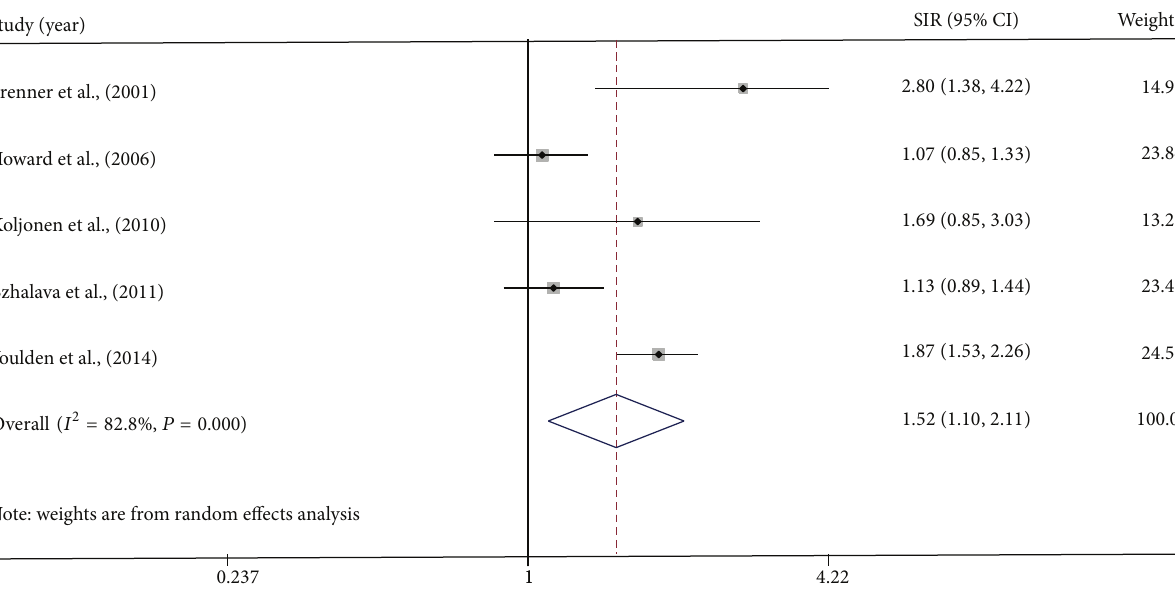
Figure 2: MCC and the risk of second cancer. Squares indicate the odds ratios for the individual studies; horizontal lines indicate the 95% confidence interval. The size of the data marker corresponds to the relative weight assigned in the pooled analysis using the random effects model. Diamond indicates the pooled odds ratios with 95% confidence